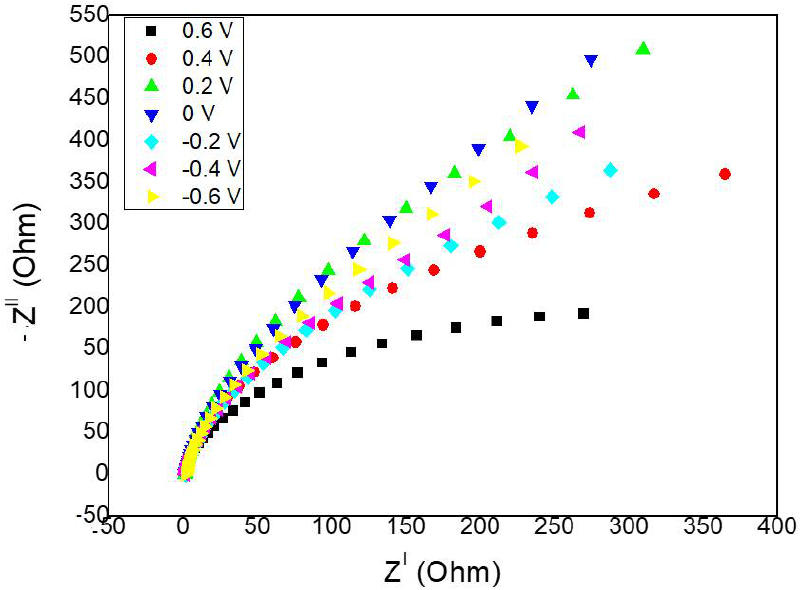
Figure 9. Electrochemical impedance spectra (EIS) on Mo/CNT/GCE at different potentials in 0.1 M PBS (pH 7.2) + 5 mM L-C. The frequency range (0.02–100,000 Hz), signal amplitude (10 mV).